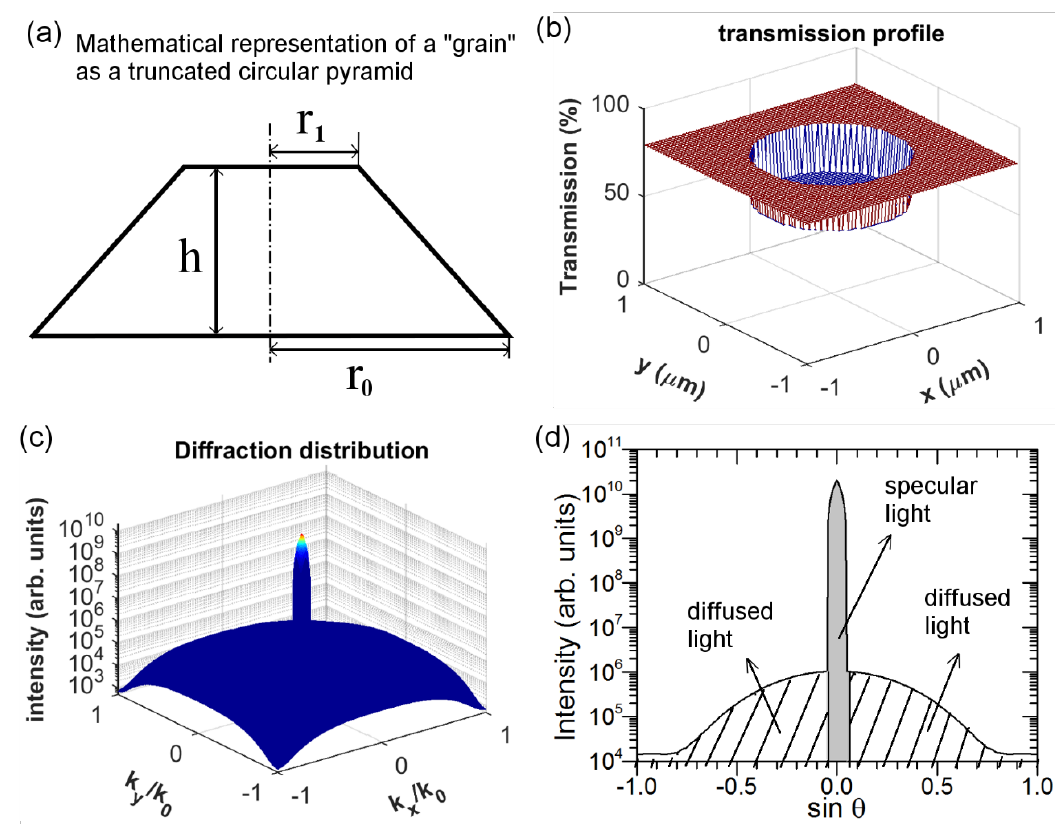
Figure 8. ( a ) Mathematical representation of an individual nanoparticle agglomerate approximated as a truncated circular pyramid described by three parameters: bottom radius r 0 , top radius r 1 , and height h; ( b ) The profile of total transmission for light passing through FTO nanocomposite containing a ZnO nanoparticle agglomerate parameterized as r 0 = 600 nm, r 1 = 200 nm, and h = 150 nm; ( c ) 3D-plot of light intensity in k-space; and ( d ) 2D-plot of light intensity, deduced as cross section at k y /k 0 = 0 (or equivalently, k x /k 0 = 0) in ( c ). The specularly (corresponding to about 3 ◦ ) and diffusely transmitted light are pointed out, respectively.